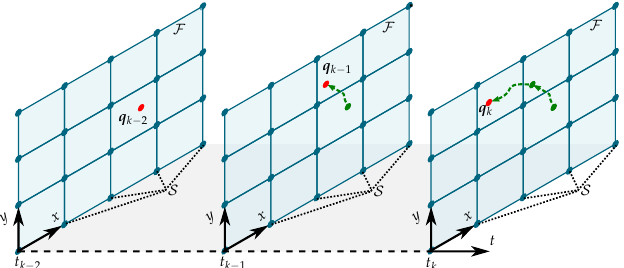
Figure 6. An agent takes measurements at the position q while maneuvering through a field F . The environmental field is discretized into a regular lattice with the set of locations S . The STKF random variables ˆ f ( t ) estimate the spatio-temporal process f ( t ) on S